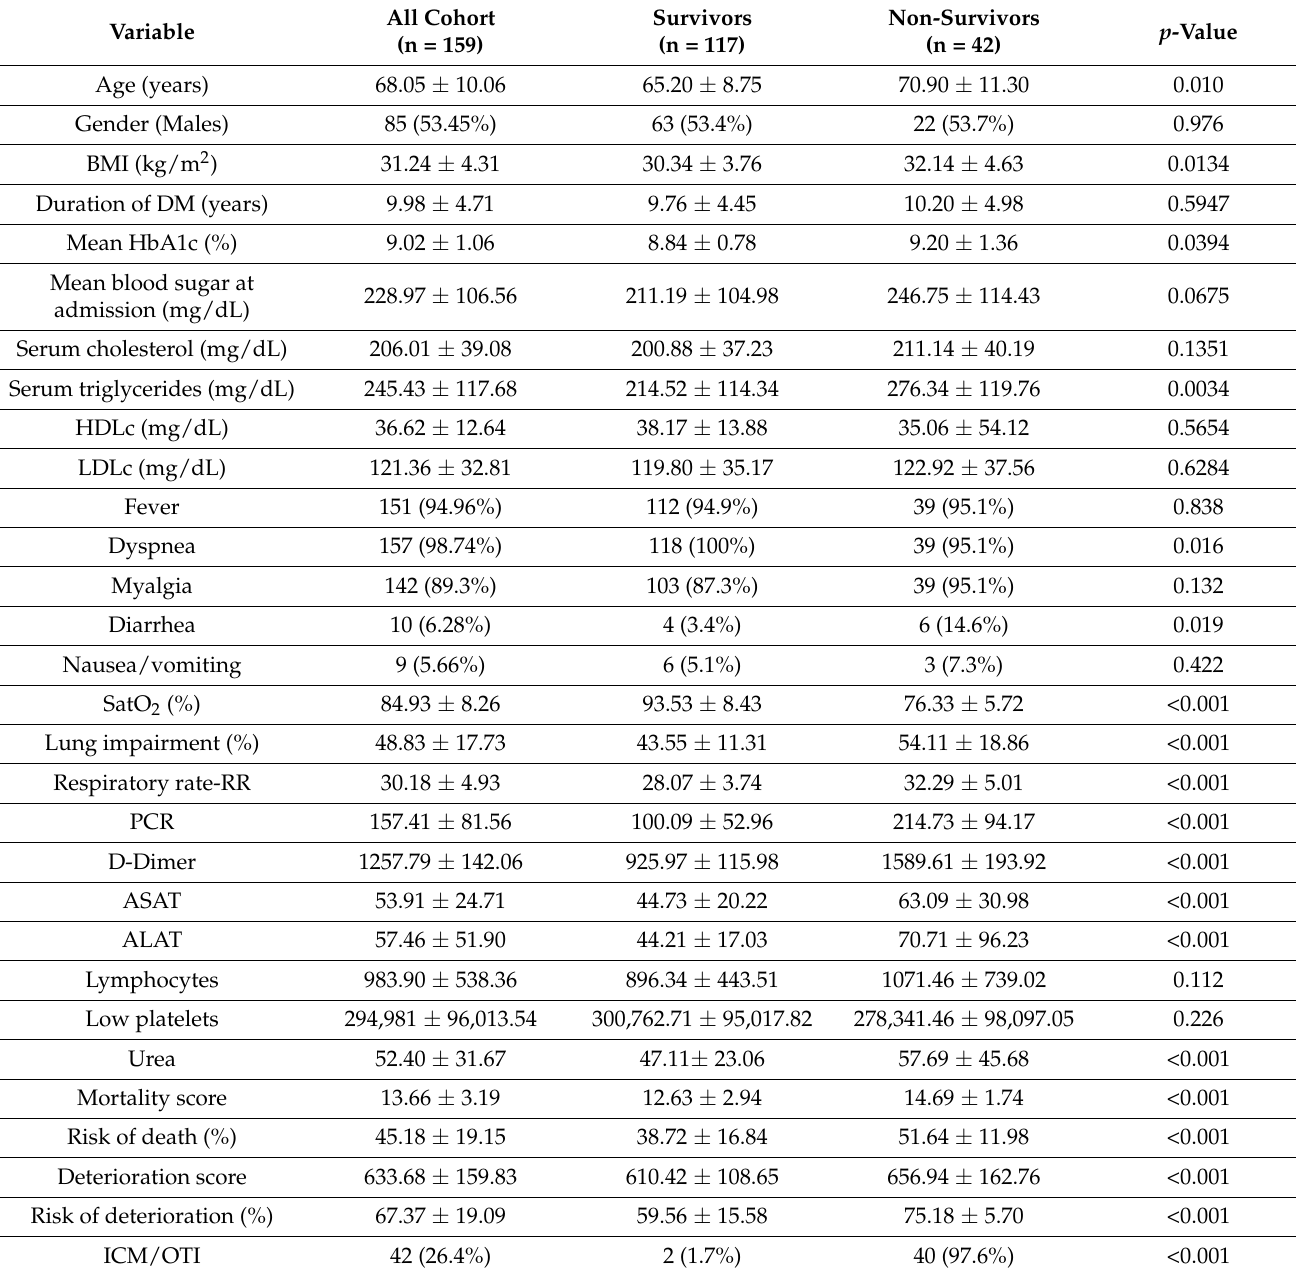
Table 1. General characterization of patients: anthropometric parameters, lipidic and glycemic profiles at